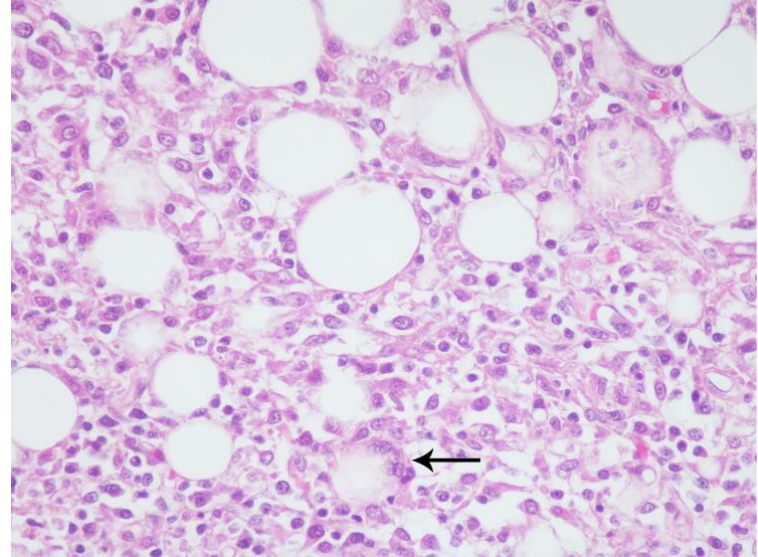
Figure 3. California sea lion, mesenteric adipose. Adipocytes vary in size and are surrounded, separated, and partially to completely replaced by epithelioid and foamy macrophages with low numbers of lymphocytes, plasma cells, and neutrophils. Rare adipocyte remnants are within multinucleated giant cells (arrow). Hematoxylin and eosin, 40× magnification.